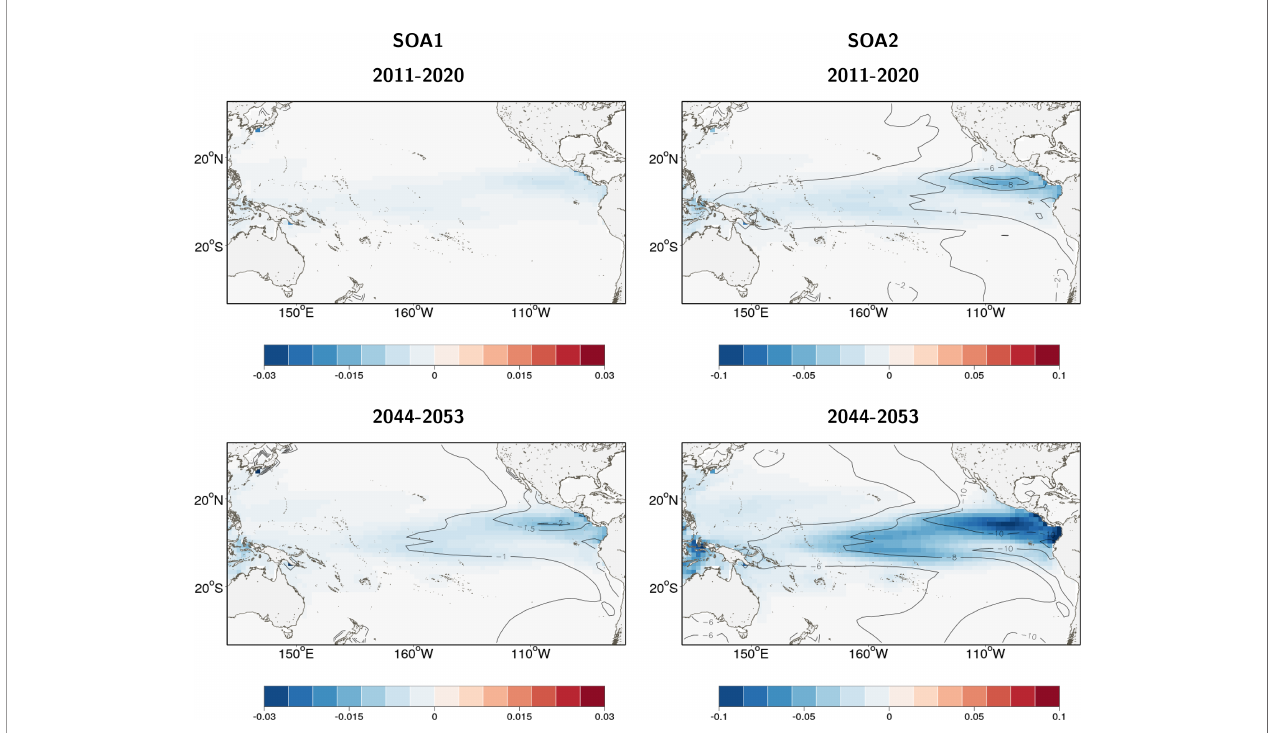
FIGURE 6 | Change in density of yellow fi n tuna larval recruits due to ocean acidi fi cation effects included in SEAPODYM, in 2015 (average of 2011-2020) and 2050 (average 2044-2053) for intermediate scenario SOA1 and high sensitivity scenario SOA2. There is no change for scenario SOA3. The color maps show the average density (thous.Nb/sq.km) change, and isopleths give the relative percentage change in density with respect to the density in respective year projected to occur without ocean acidi fi cation effect under a high emission scenario (RCP8.5) with 2 atmospheric forcings derived from Earth Climate